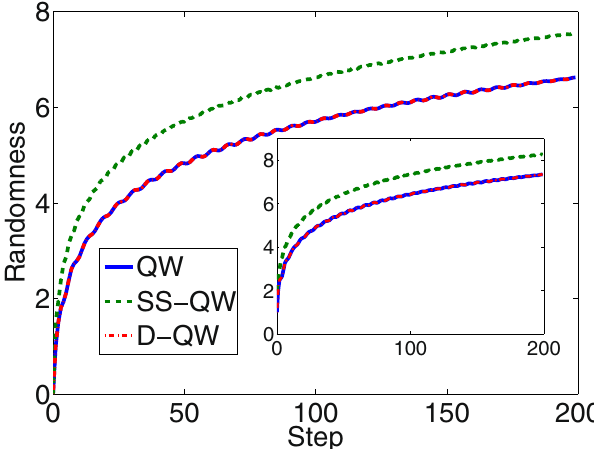
Figure 4. Randomness with number of steps in standard DTQW, SS-QW, and D-QW. Due to non-zero probability at all position space in SS-QW we can see a maximum randomness compared to other two. Amount of randomness measure corresponds to equivalent number of qubit it can mimic in the process. Inset in the figure is the randomness when both coin and position space are taken